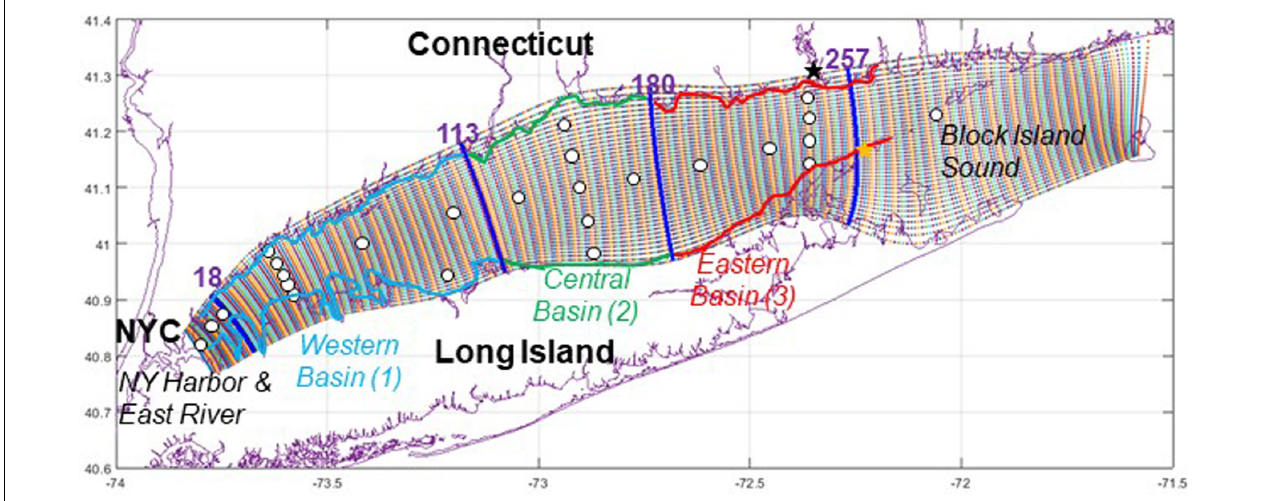
FIGURE 1 | The study site of Long Island Sound, bound between Long Island (NY), and Connecticut. Surface and bottom sampling stations are indicated by white circles. The mouth of the Connecticut River is indicated by a black star; Orient Point is indicated by an orange star. Long Island Sound is subdivided into the western (light blue), central (green), and eastern (red) basins, after Garcia-Orellana et al. (2014). Purple numbers correspond to the cross-section numbers in Table 1 . Mean water exchange transports through cross-sections 18 113, 180, and 257 (N-S oriented dark blue lines) are derived from the three-dimensional model of Crowley (2005); the two-dimensional grid used in the model calculations is shown for reference and overlaps the land-ocean